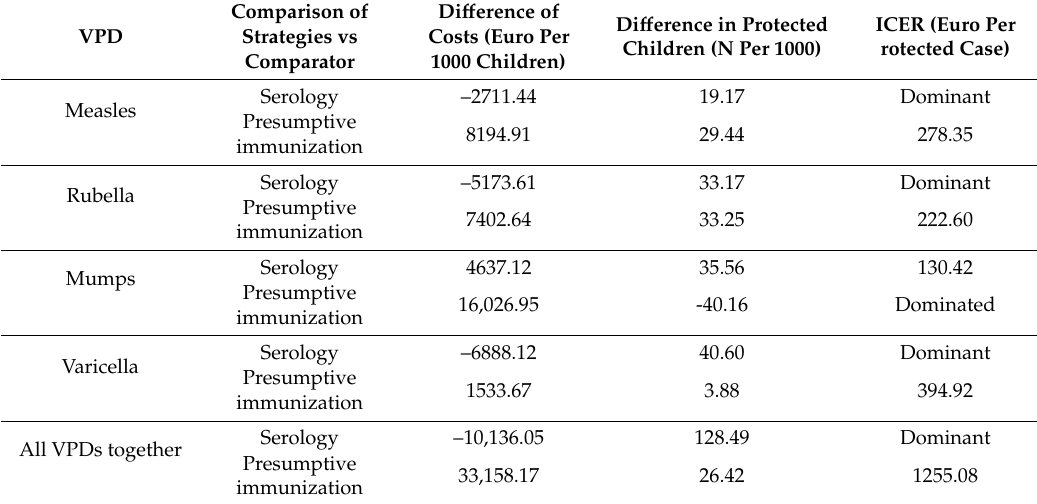
Table A6. Comparison of strategies according to di ff erent VPDs excluding children < 1 year of age (CLIA